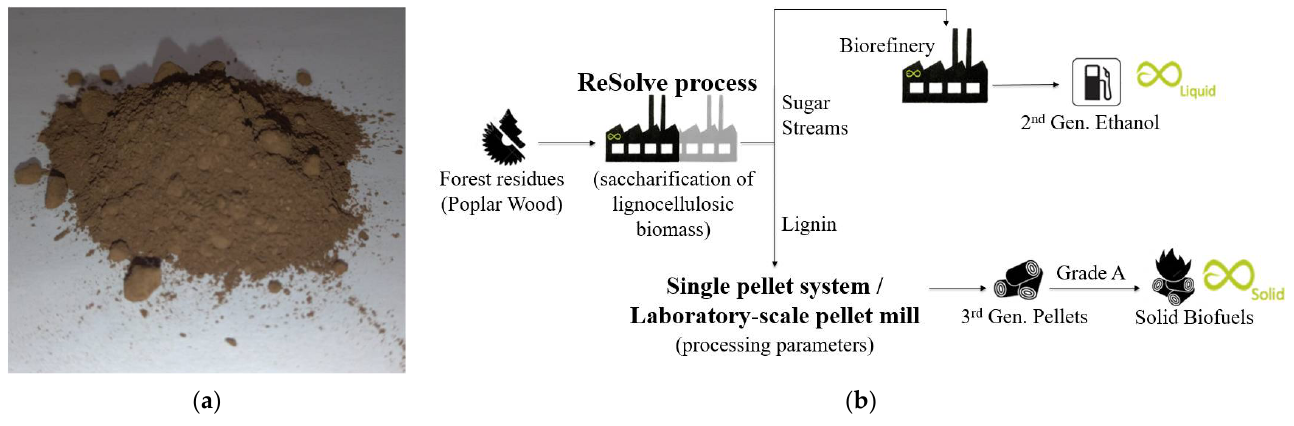
Figure 1. ( a ) Poplar wood-based lignin produced at pilot scale using ReSolve process and ( b ) block diagram of the ReSolve process, which is the source of the lignin used in this work.